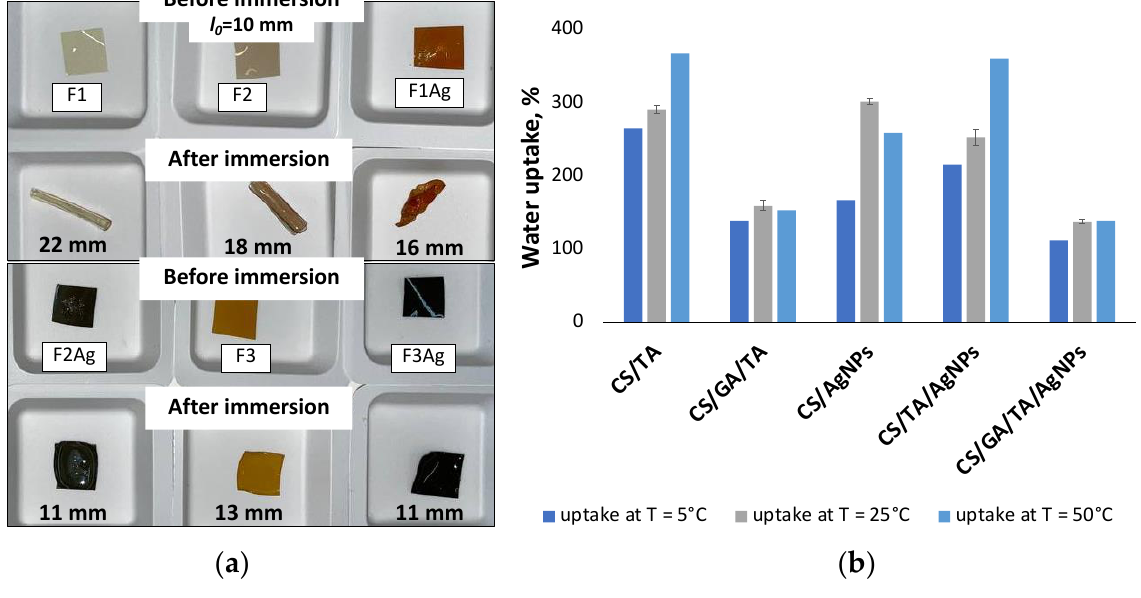
Figure 6. ( a ) Photos of the films before and after immersion and incubation in water, ( b ) water uptake graphs of films with different compositions under different incubation temperatures (5, 25, 50 °C).